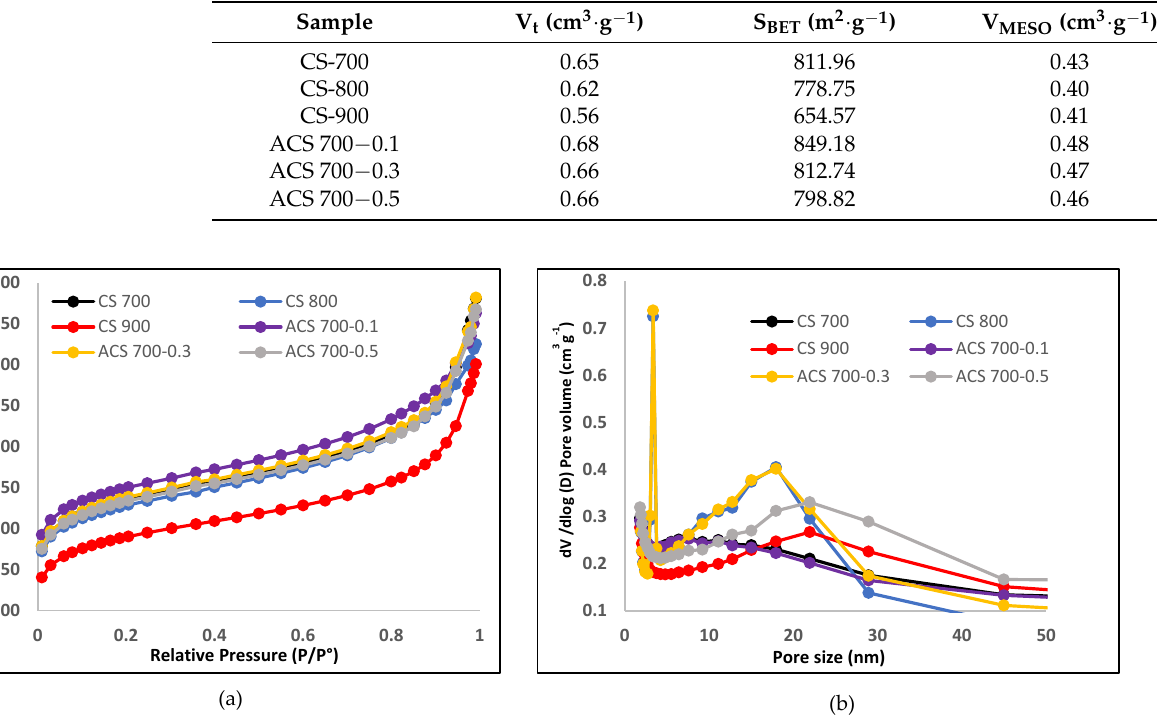
Figure 4. ( a ) Nitrogen adsorption–desorption isotherm of CS 700, CS 800, CS 900, ACS 700−0.1, ACS 700−0.3, and ACS 700−0.5. ( b ) Pore width distribution of CS 700, CS 800, CS 900, ACS 700−0.1, ACS 700−0.3, and ACS 700−0.5.